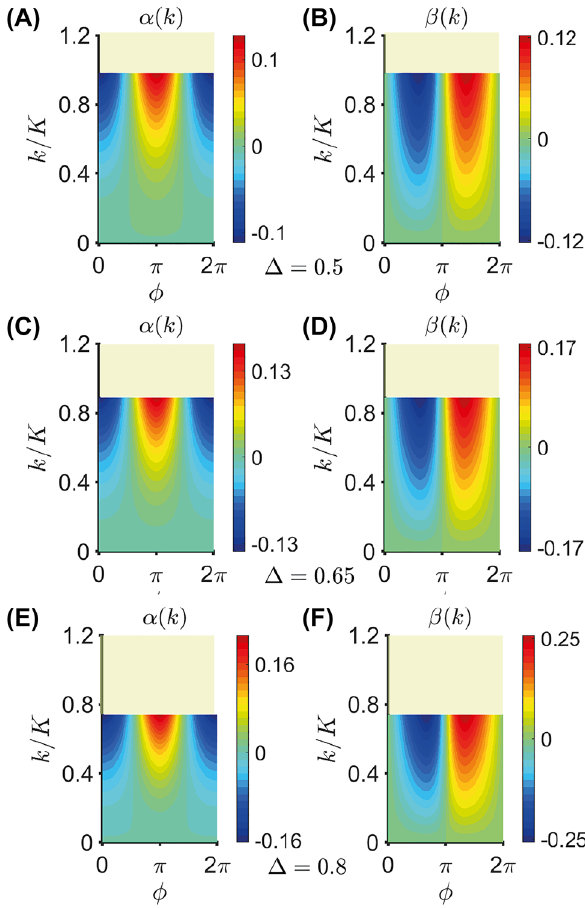
Figure 4: Nonlocal contributions in Eq. (14) as a function of k ∕ K and 𝜙 , for Δ = 0 . 5 ((A) and (B)), Δ = 0 . 65 ((C) and (D)), and Δ = 0 . 8 ((E) = 0 and a temporal metamaterial with the and (F)). Here, t 0 permittivity profile in Eq. (10) is considered, with 𝜀 = 5. The parameters are only shown within the region where the nonlocal EMT holds ( ≲ 10 % error with respect to full-wave